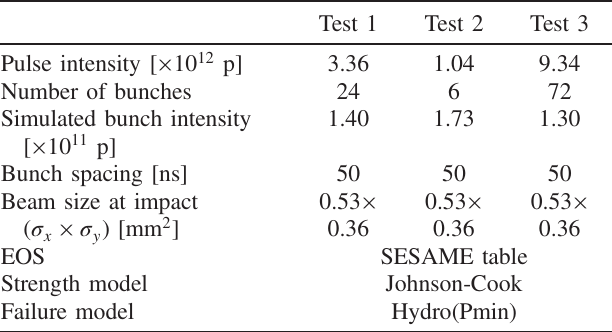
TABLE VII. Beam characteristics and jaw material models adopted for AUTODYN ® simulations.